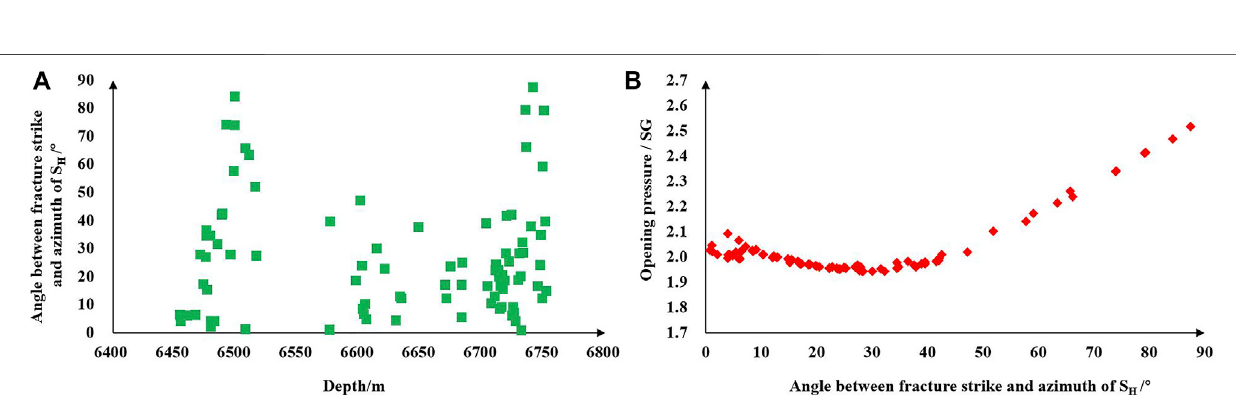
Frontiers in Earth Science |